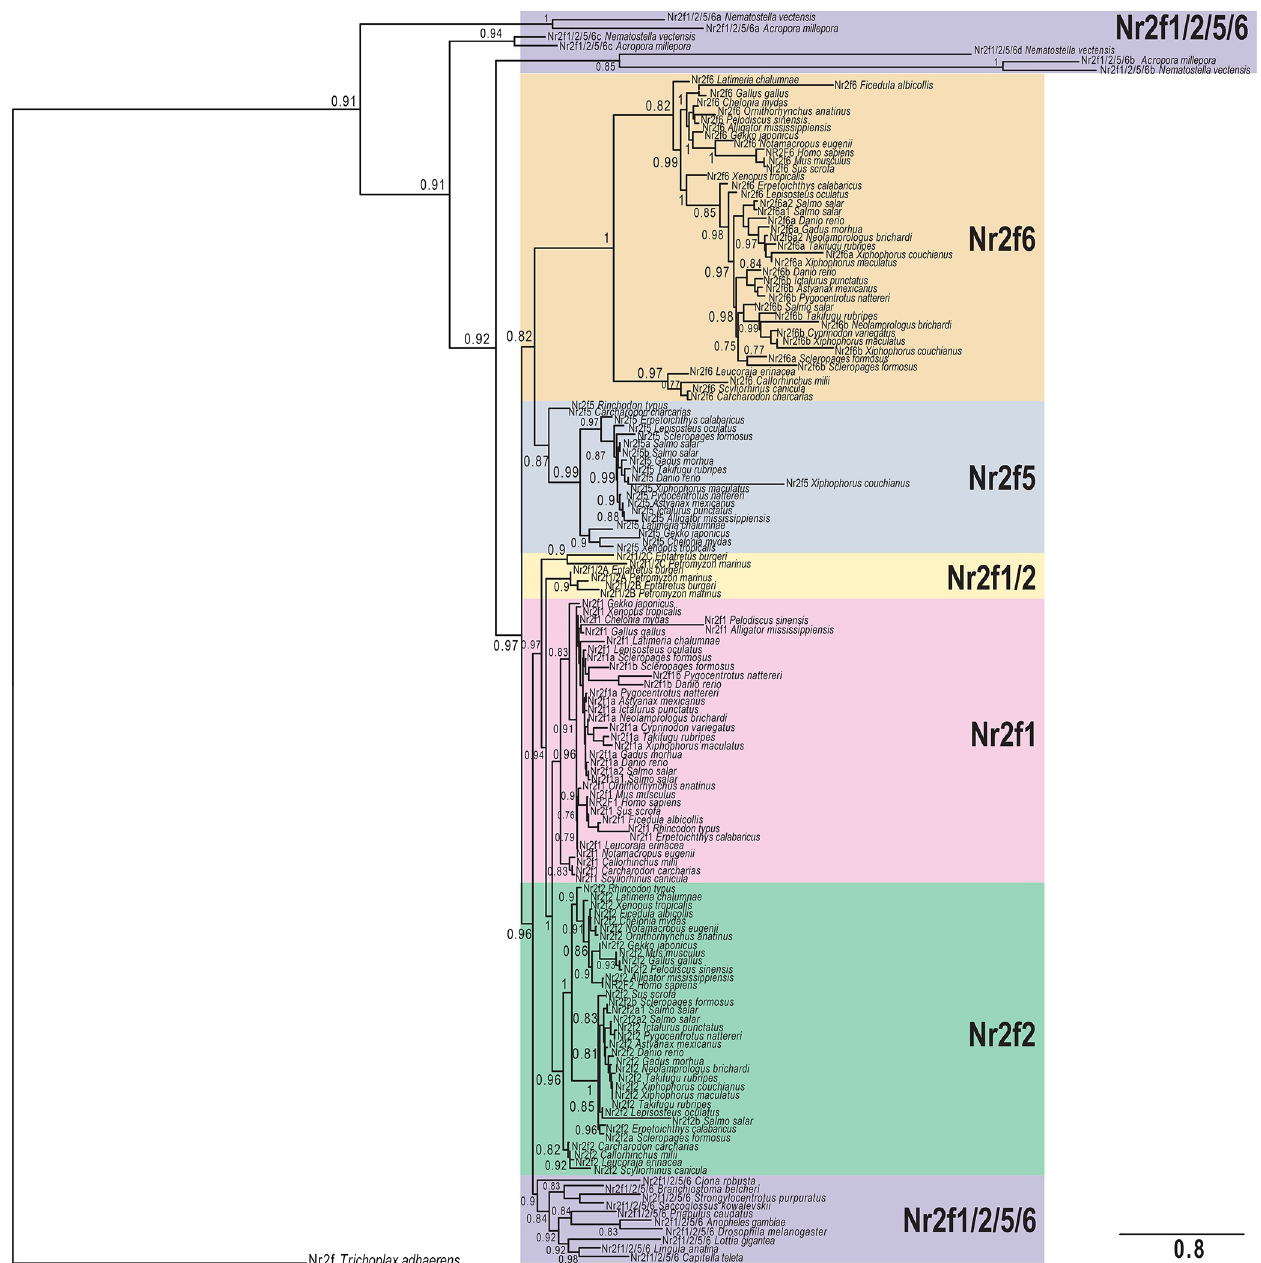
Fig 2. Evolutionary reconstruction of Nr2f TFs in metazoans. Phylogenetic tree of Nr2f members demonstrate the existence of six protein classes: Nr2f1/2/ 5/6 (violet box), Nr2f1/2 (yellow box), Nr2f1 (pink box), Nr2f2 (green box), Nr2f5 (blue box), Nr2f6 (orange box). The placozoan Trichoplax adhaerens Nr2f was used as the outgroup. Values at the branches indicate replicates obtained using the aLRT